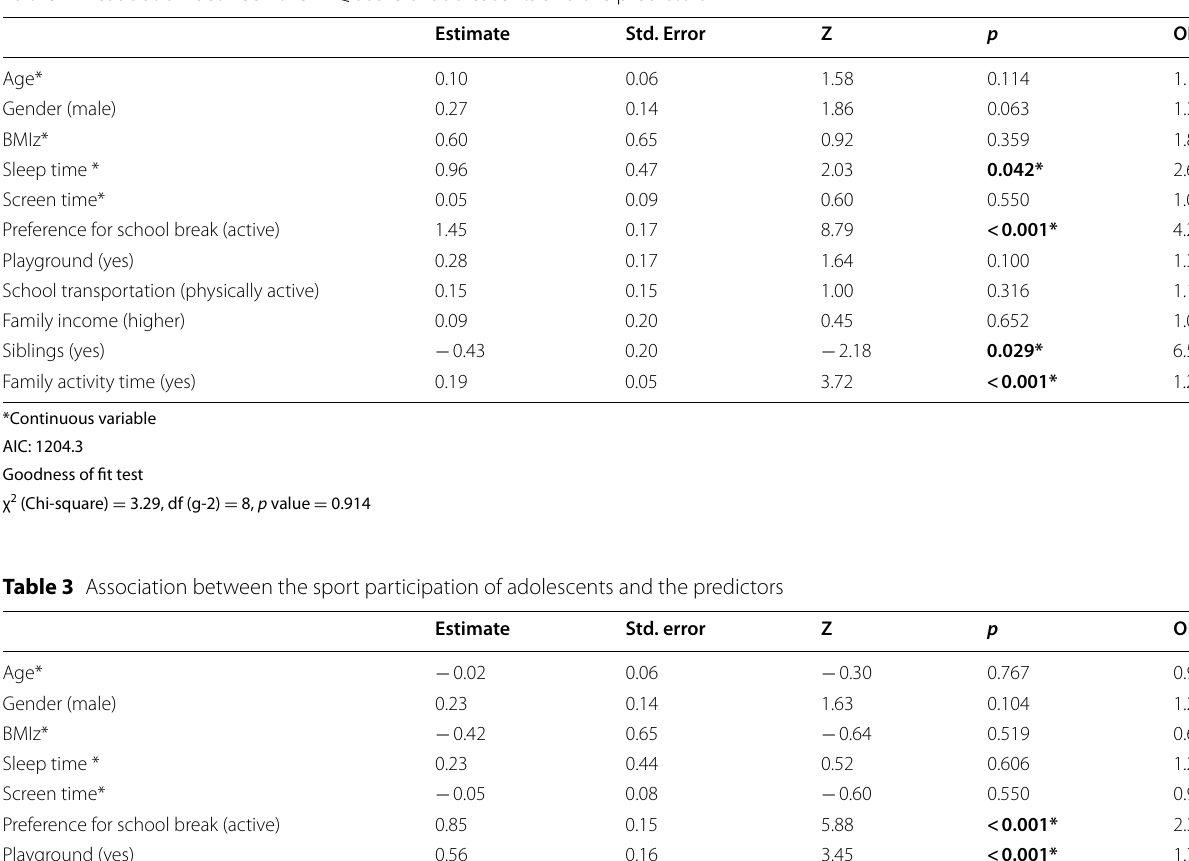
Table 2 Association between the PAQ score of adolescents and the predictors